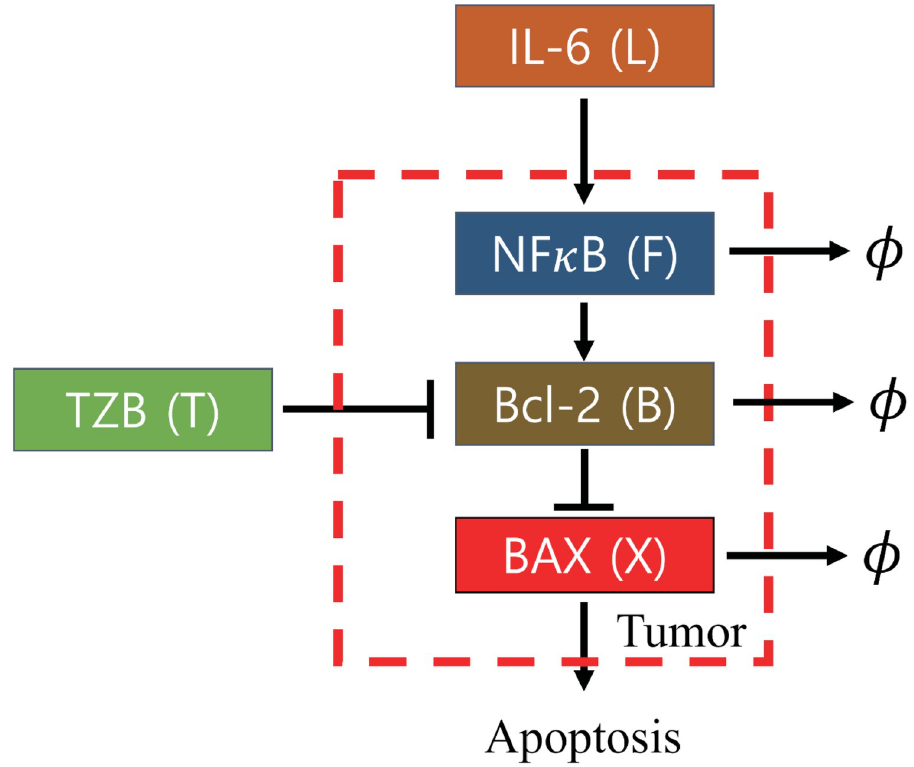
Fig 2. Conceptual model of regulation of intracellular variables (NF κ B, Bcl-2, and BAX) with extracellular stimuli (IL-6 and TZB) in the tumor cell apoptosis process